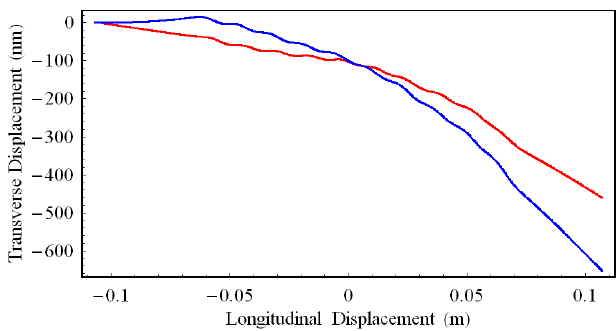
FIG. 12. (Color) Calculated trajectory in the transverse x (red) and y (blue) directions for the PPM